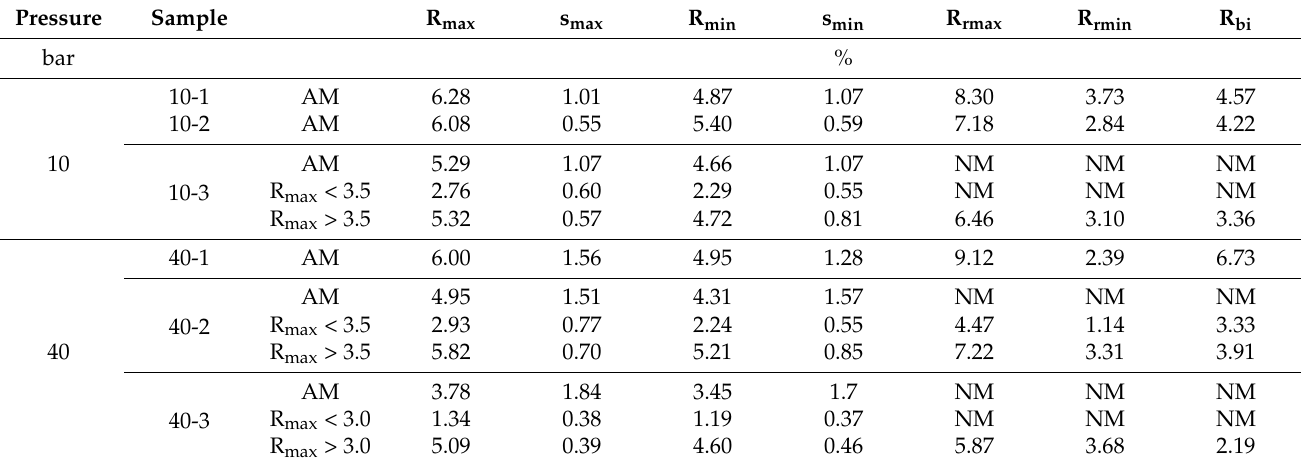
Figure 9. Relationship between ( a ) R max ; ( b ) R rmax (pressure of 10 bar); ( c ) R rmax (pressure of 40 bar); ( d ) R bi and distance d from the reactor chamber inlet. Table 3. Characteristics of the optical properties of the raw sample and the residues after coal